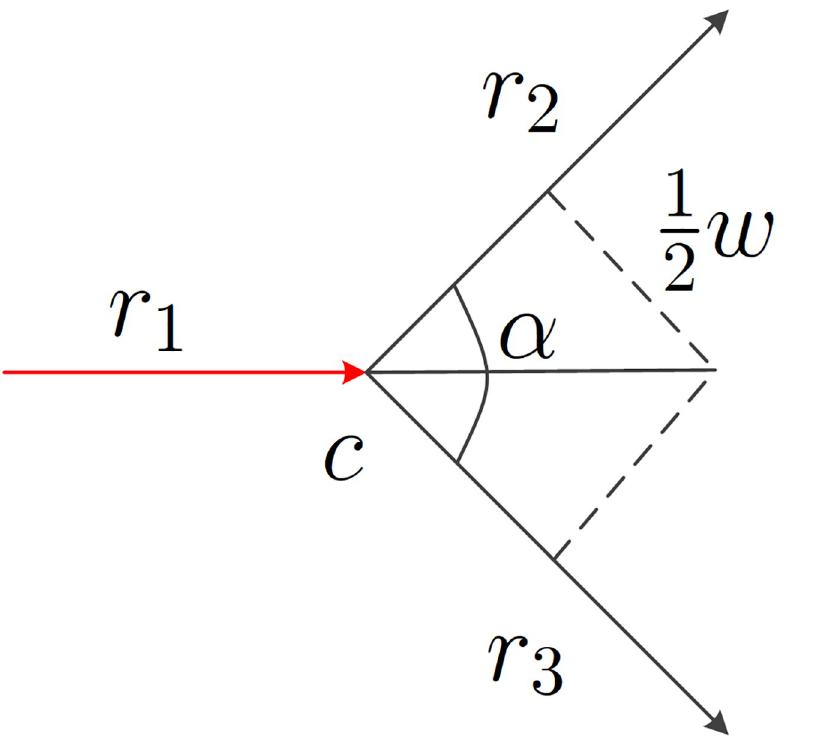
Fig 8. Calculation of the intersection